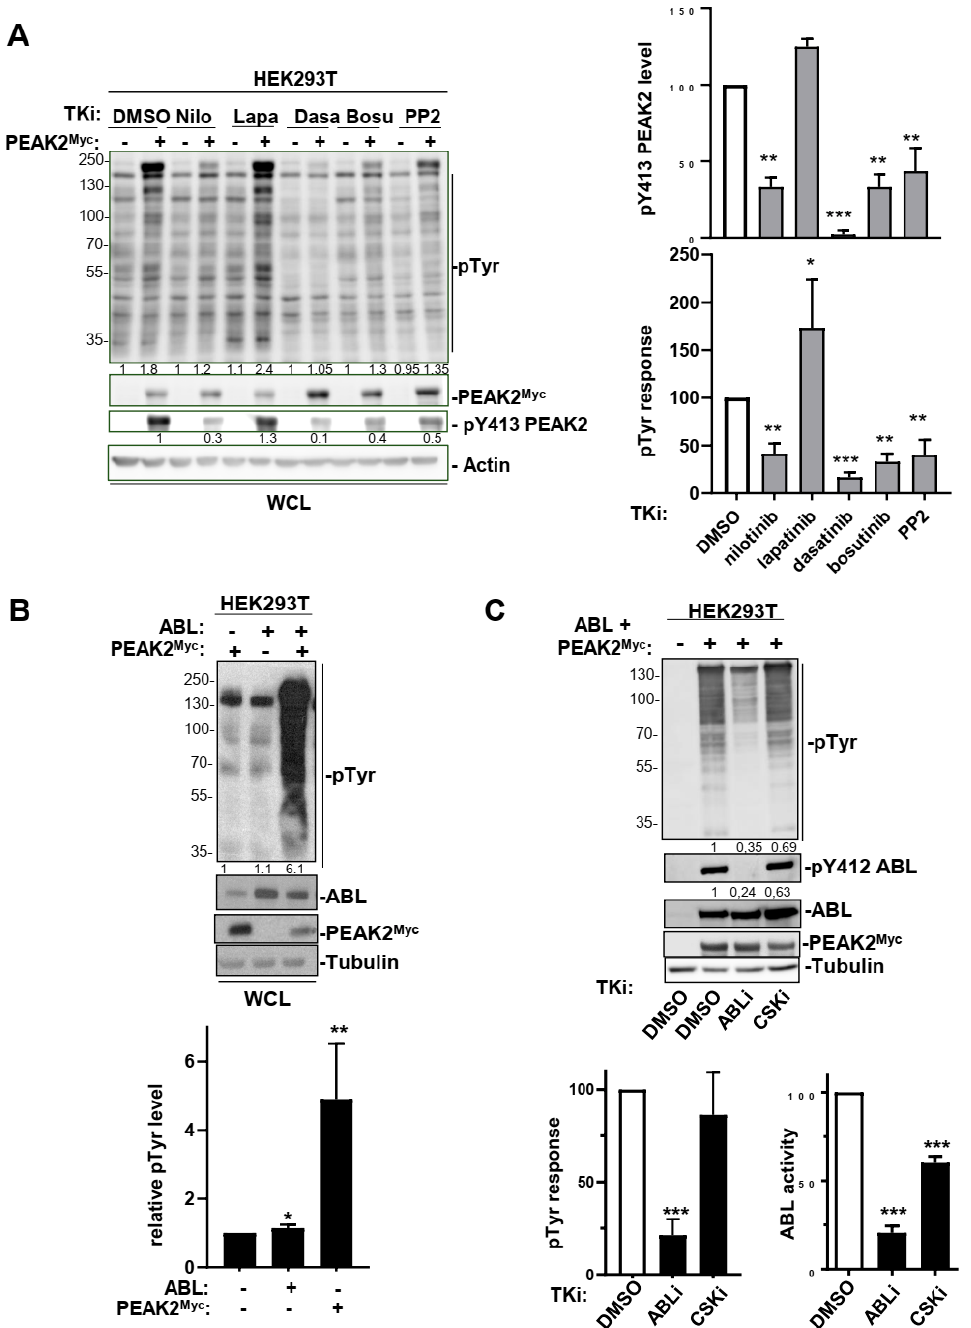
Figure 6. An interplay between ABL and PEAK2 activity. ( A ) Protein tyrosine phosphorylation induced by PEAK2 expression is diminished upon ABL pharmacological inhibition. Is shown the level of protein tyrosine phosphorylation of HEK293T cells transfected with PEAK2 Myc and treated for 2 h with indicated TK inhibitors (0.1% DMO; nilotinib, dasatinib and bosutinib: 100 nM; PP2 and lapatinib: 5 µM). The levels of PEAK2 Myc , pY413 PEAK2 and protein tyrosine phosphorylation (pTyr). Right panels represent the relative quantification of indicated signals (mean ± SEM; n = 3; * p < 0.05; ** p < 0.01; *** p < 0.001 Student’s t -test). ( B ) ABL activity potentiates PEAK2 Myc -induced protein tyrosine phosphorylation in HEK293T cells. ( C ) CSK does not play a major role in this activation process. Transfected cells were treated for 3 h with indicated TK inhibitors (ABLi nilotinib: 100 nM; CSKi: 100 nM). Bottom panels represent the relative quantification of indicated signals (mean ± SEM; n = 3; * p < 0.05; ** p < 0.01; *** p < 0.001 Student’s t